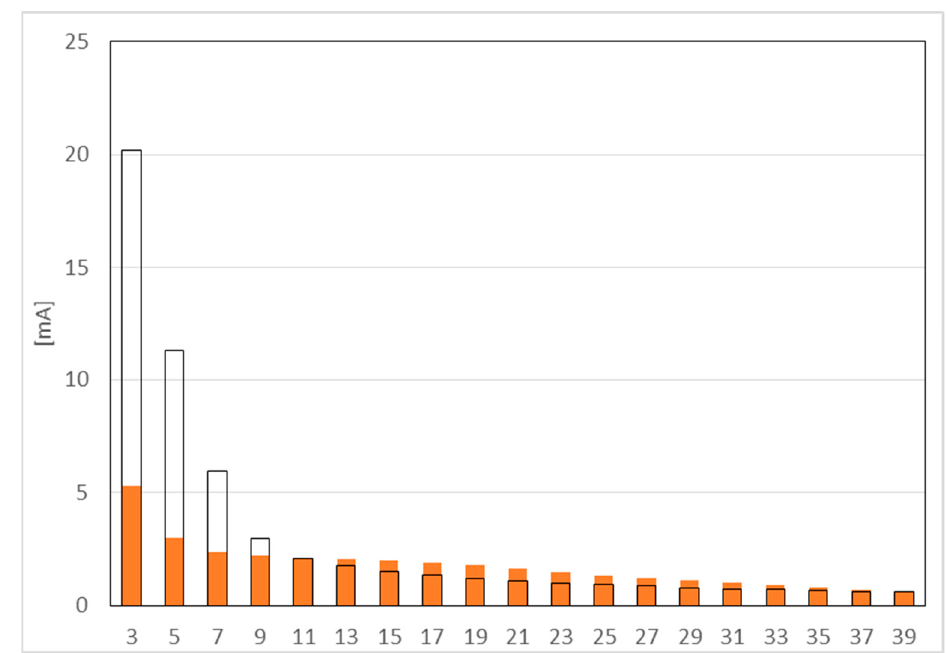
Figure 6. Harmonic emissions test.